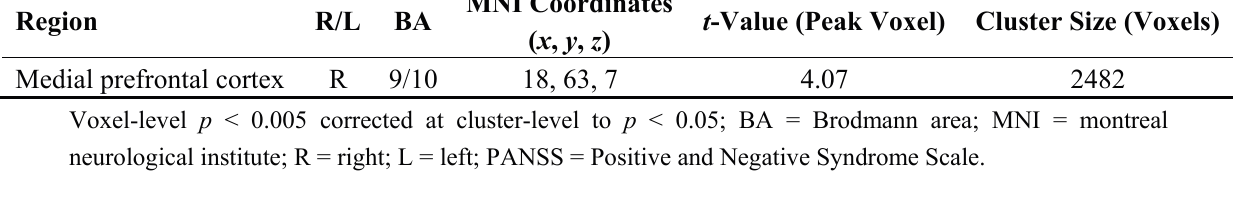
Table 5. Correlational analysis of GMD in significant clusters (covarying for PANSS negative scores) and metacognition.